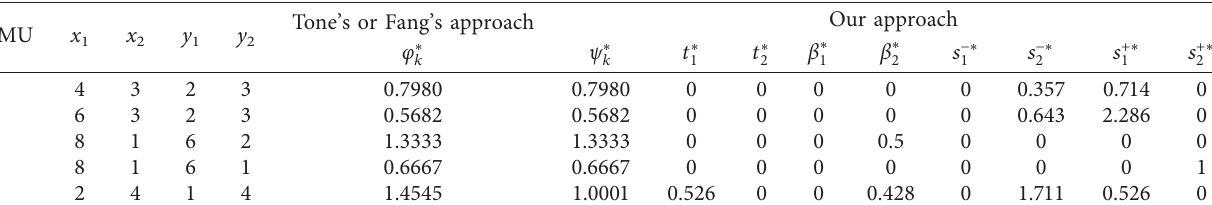
Table 4: Data set 2 from Tone [14] and results from our